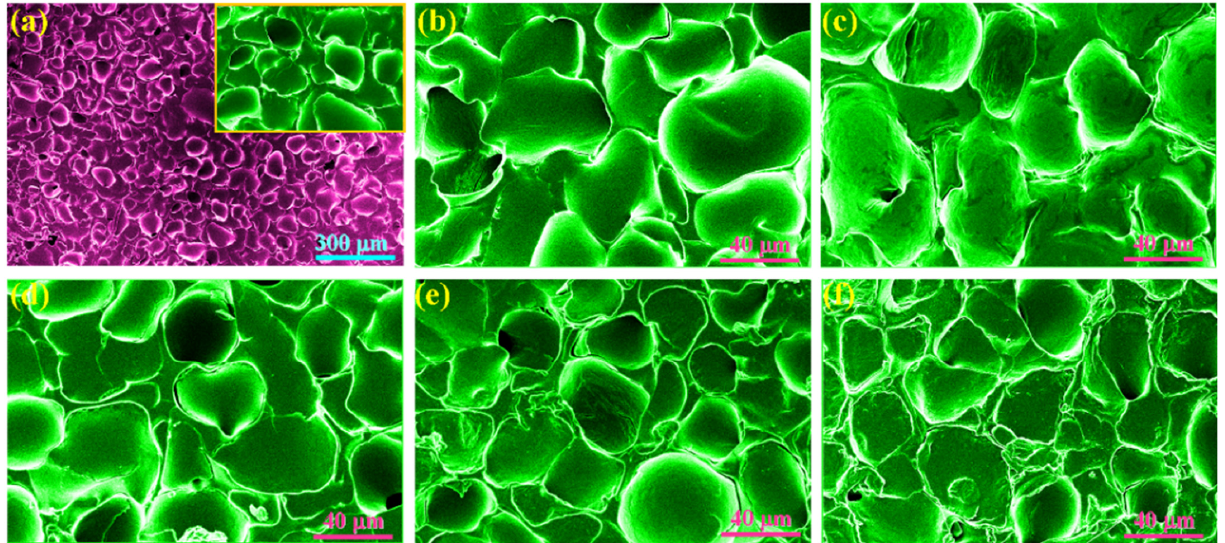
Figure 8. SEM images of ( a ) pure PI aerogel/PEG composite film and the PI/graphene/Fe 3 O 4 aerogel/PEG composite films with a graphene content of 5 wt% and different Fe 3 O 4 contents of ( b ) 0, ( c ) 2, ( d ) 4, ( e ) 6, and ( f ) 8 wt%.